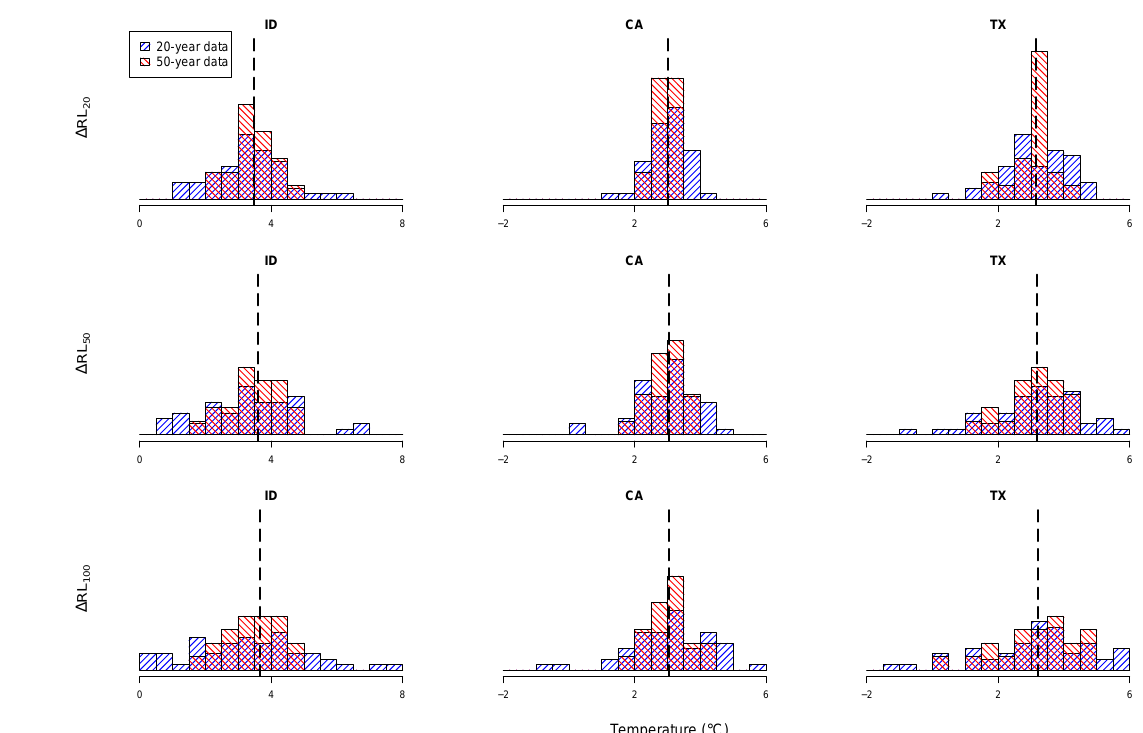
Figure 10. The relationship between sample errors for return levels and data lengths for warm extremes. Estimates of changes (from pre- industrial to 700ppm CO 2 ) in return levels (20-, 50-, 100-year return periods) obtained by using different length segments (20 and 50 years, shown as blue and red histograms), as compared to the “ground-truth” changes obtained with the full 1000-year runs (dashed lines). We show warm extremes for the same three grid cells shown in previous figures, located in Idaho, California, and Texas. Pre-industrial return levels for these locations (for 20-, 50-, and 100-year periods) are ID: 30.4, 31.1, and 31.5 ◦ C; CA: 29.4, 29.8, and 30.1 ◦ C; and TX: 38.1, 38.9, and 39.4 ◦